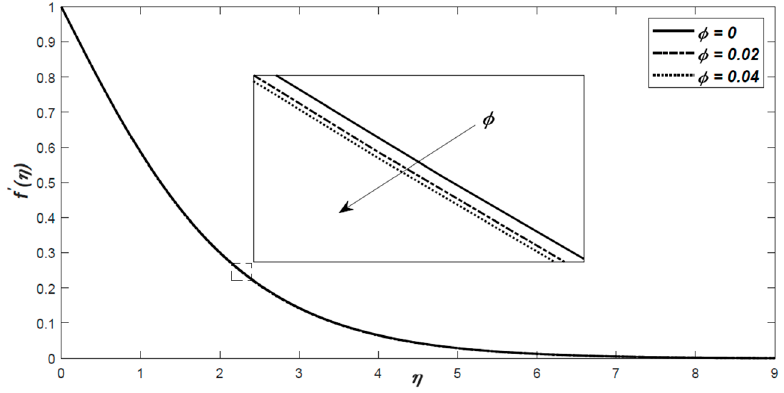
Figure 3. The dimensionless velocity profiles with 𝜙 for Al 2 O 3 –water with respect to similarity variable 𝜂 .